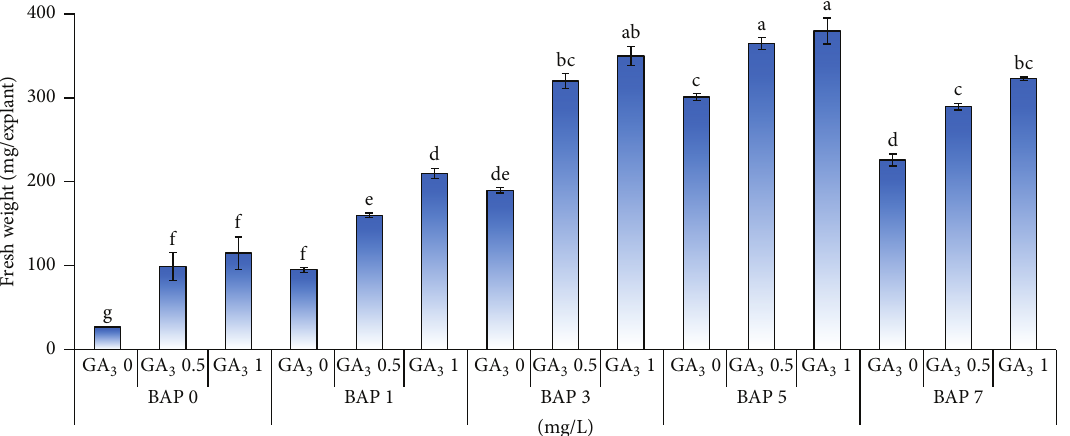
Figure 4: Changes in fresh weight per explant basis as affected by different concentrations of BAP (mg/L) in combination with GA 3 (mg/L) for tea clone Iran